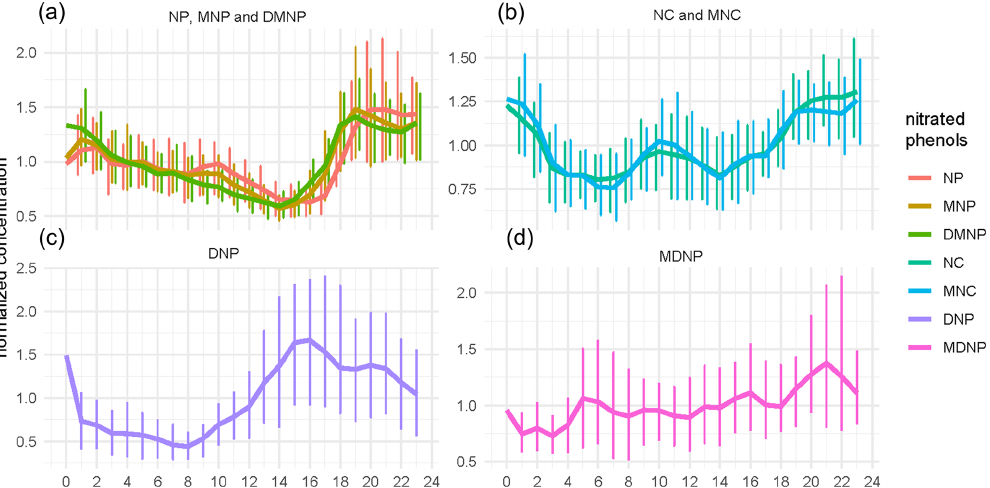
Figure 3. Diurnal profiles of nitrated phenols (NPs) with 95% confidence interval shown by the error bars. The concentration of NPs was normalized by their mean values. (a) Diurnal profiles of nitrophenol (NP), methyl-nitrophenol (MNP), and dimethyl-nitrophenol (DMNP). These are NPs with one –OH group and one –NO 2 group. (b) Diurnal profiles of nitrocatechol (NC) and methyl-nitrocatechol (MNC). These are NPs with two –OH groups and one –NO 2 group). Diurnal profiles of (c) dinitrophenol (DNP) and (d) methyl-dinitrophenol (MDNP). These are NPs with one –OH group and two –NO 2